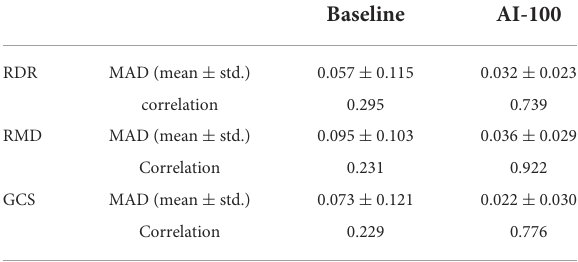
TABLE 8 Mean absolute difference and Pearson correlation of prediction scores on pairwise images of same eye and different cameras.